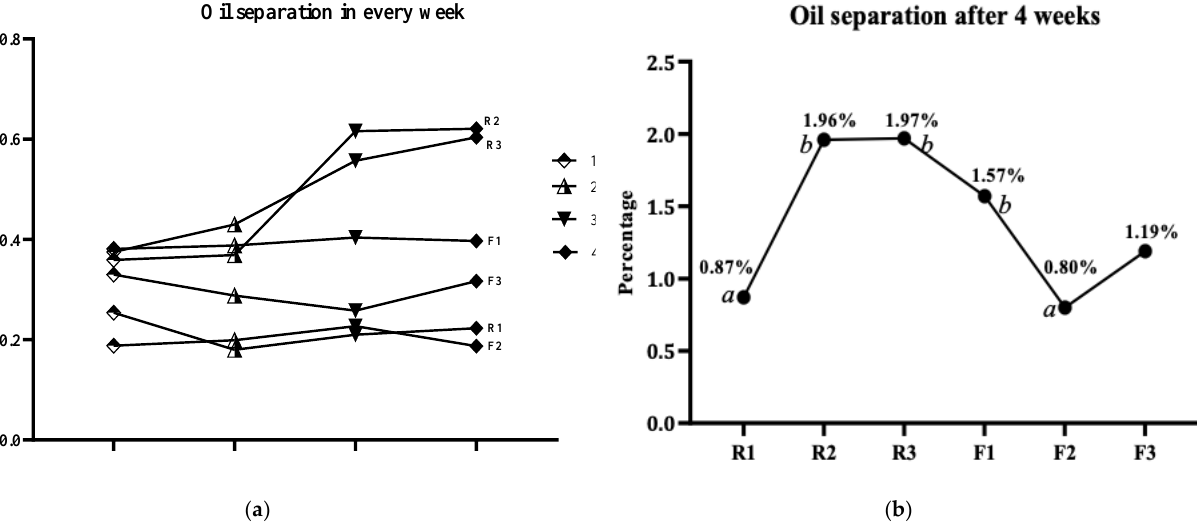
Figure 6. Oil separation percentage of the peanut butter samples. a = values were significantly ( p < 0.05) different for using rice bran wax oleogel in sample F1; b = values were significantly ( p < 0.05) different for using carnauba wax oleogel in sample F2. R1 = rice bran wax added sample; R2 = carnauba wax added sample; R3 = un-stabilized butter from natural peanut (control); F1 = rice bran wax oleogel added sample; F2 = carnauba wax oleogel added sample; F3 = un-stabilized butter from peanut